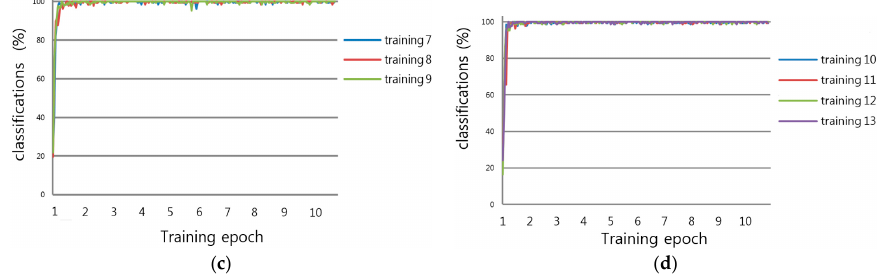
Figure 11. Classification accuracies of training data over 13-fold cross validation; “classifications” means “classification accuracy of training data”: ( a ) Training 1–3; ( b ) Training 4–6; ( c ) Training 7–9; ( d ) Training 10–13.